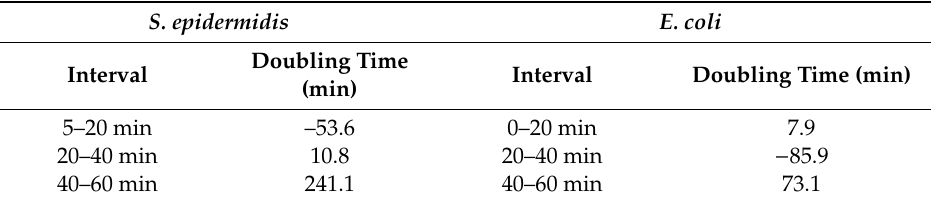
Table 4. Estimates of the signal doubling time of PI (red) fluorescence emission in two assays of Product